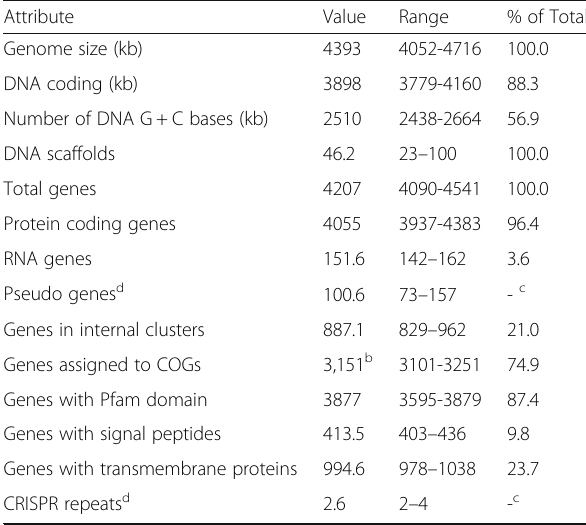
Table 4 Summary of the genome statistics of the 26 C. sakazakii strains evaluated in this study